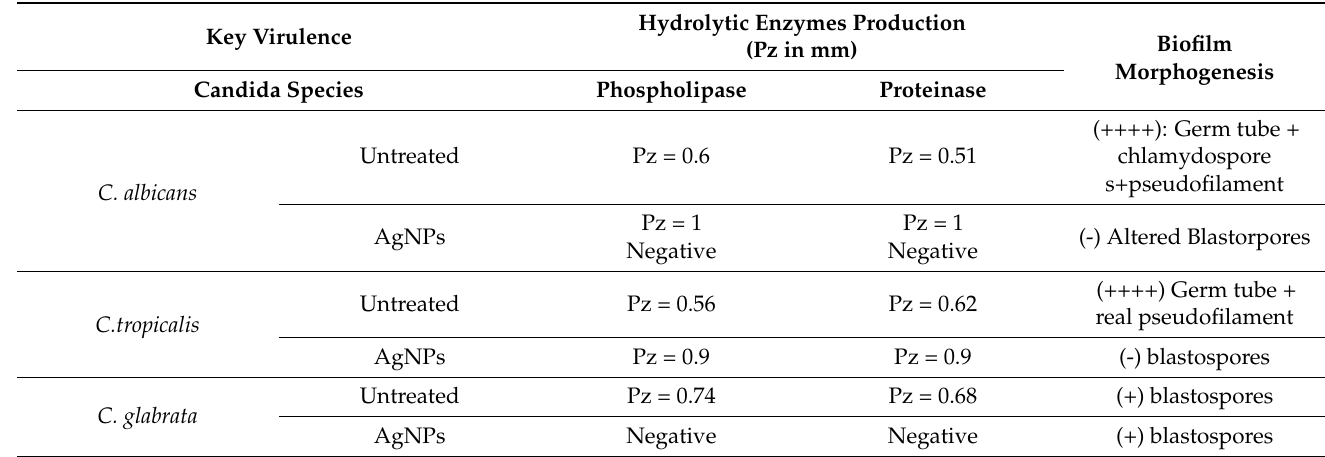
Table 3. Comparison of the virulence factor production by Candida species in the absence (Untreated) and in the presence of AgNPs (treated by the AgNPs) after 48 h of incubation at 37°C.